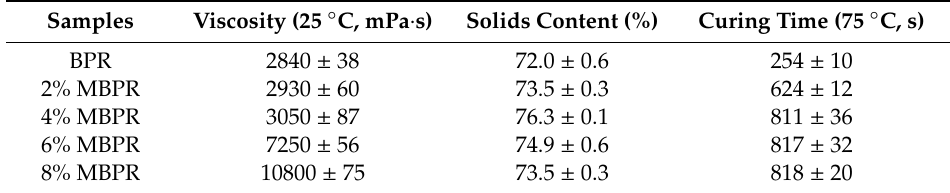
Table 1. Basic characteristics of bio-oil phenolic resin (BPR) and bio-oil phenolic resins modified by montmorillonite